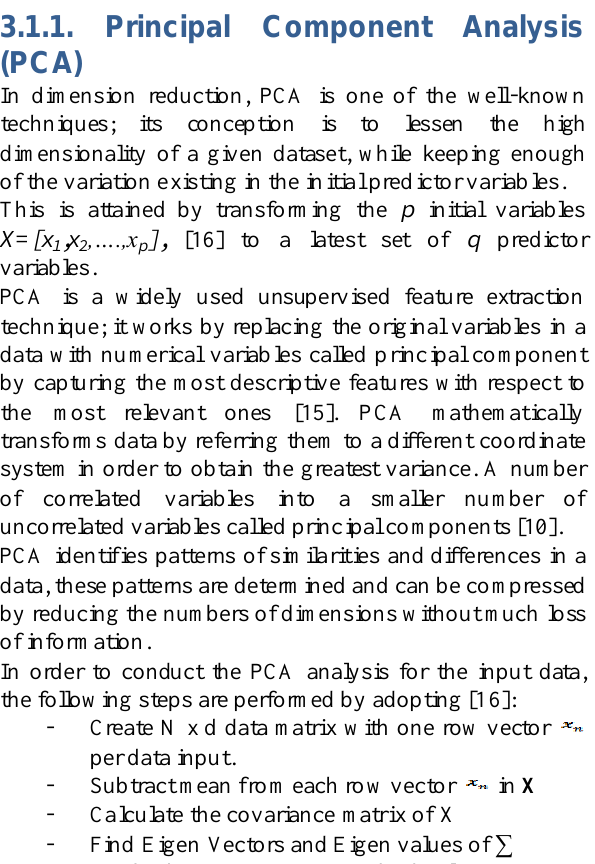
Figure 1. Technique